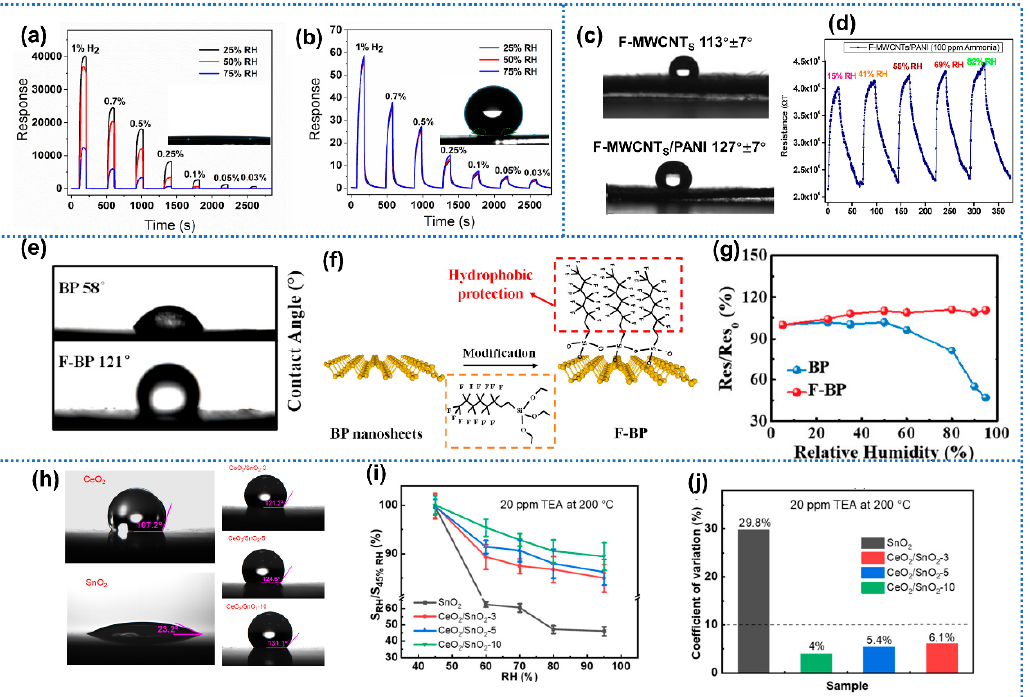
Figure 5. The real-time responses of pristine Pd/TiO 2 NTs and Pd/TiO 2 NTs coated by PDMS for 7 h to different concentrations of H 2 under different RH environments at 25 °C. The insets of ( a ) and ( b ) showed a water droplet on each surface. Reprinted with permission from Ref. [83]. Copyright 2020, Elsevier. ( c ) Water contact angles of the MWCNTs and MWCNTs/PANI on fabric substrates. ( d ) The dynamic curves of the MWCNTs/PANI sensor at different RH% (15–82%) for 1 ppm NO 2 . Reprinted with permission from Ref. [84]. Copyright 2018, American Chemical Society. ( e ) Water contact angle of BP and F-BP films. ( f ) Schematic illustration of the preparation of F-BP. ( g ) Relative sensing re- sponse of the sensor to NO 2 with different RH environments, where R es0 is the response in dry air and R es is the response in humidity. Reprinted with permission from Ref. [89]. Copyright 2021, American Chemical Society. ( h ) Water contact angle of SnO 2 , CeO 2 , and CeO 2 /SnO 2 films. ( i ) Plots of response retentions for different sensors as a function of RH. ( j ) CV of different sensors under RH in the range of 45 − 96%. Reprinted with permission from Ref. [100]. Copyright 2022, American Chemical Society. 3.1.4. Modification with Hydrophilic Materials Of note, the presence of water vapor in atmospheric air is inevitable; therefore, intro- ducing absorbents to capture water molecules is one simple strategy. Hydrophilic addi- tives could serve as an effective water molecule reservoir to protect gas-sensing centers from humidity interference. Kim et al. [101] proposed NiO-doped hierarchical SnO 2 for CO detection. After doping from 0.64 to 1.27 wt% NiO, the NiO-SnO 2 sensors exhibited negligible humidity dependence toward 50 ppm CO at 375 °C when sensors were exposed to dry and 25% RH atmosphere, respectively. The diffuse-reflectance Fourier transform infrared measurements revealed that most of the water-driven species were predomi- nantly absorbed by NiO rather than SnO 2 . Therefore, the interaction between water mol- ecules and the SnO 2 surface was effectively blocked within NiO-SnO 2 sensors, allowing for sufficient oxygen species on SnO 2 to react with CO even in humid conditions. Taking advantage of the good affinity of NiO to water, Yang et al. [102] synthesized metal-organic frameworks (MOFs) derived porous NiO/NiFe 2 O 4 nanocubes for acetone detection (Fig- ure 6a). The NiO/NiFe 2 O 4 sensor presented similar dynamic resistance curves toward 100 ppm acetone in a wide humidity range of 35–95% RH as shown in Figure 6b. The response drift (S 35% RH − S 95% RH )/S 35% RH ) of NiO/NiFe 2 O 4 sensor was only 9.5%, indicating the negligi- ble humidity interference. Furthermore, Jin et al. [103] investigated the effect of NiO